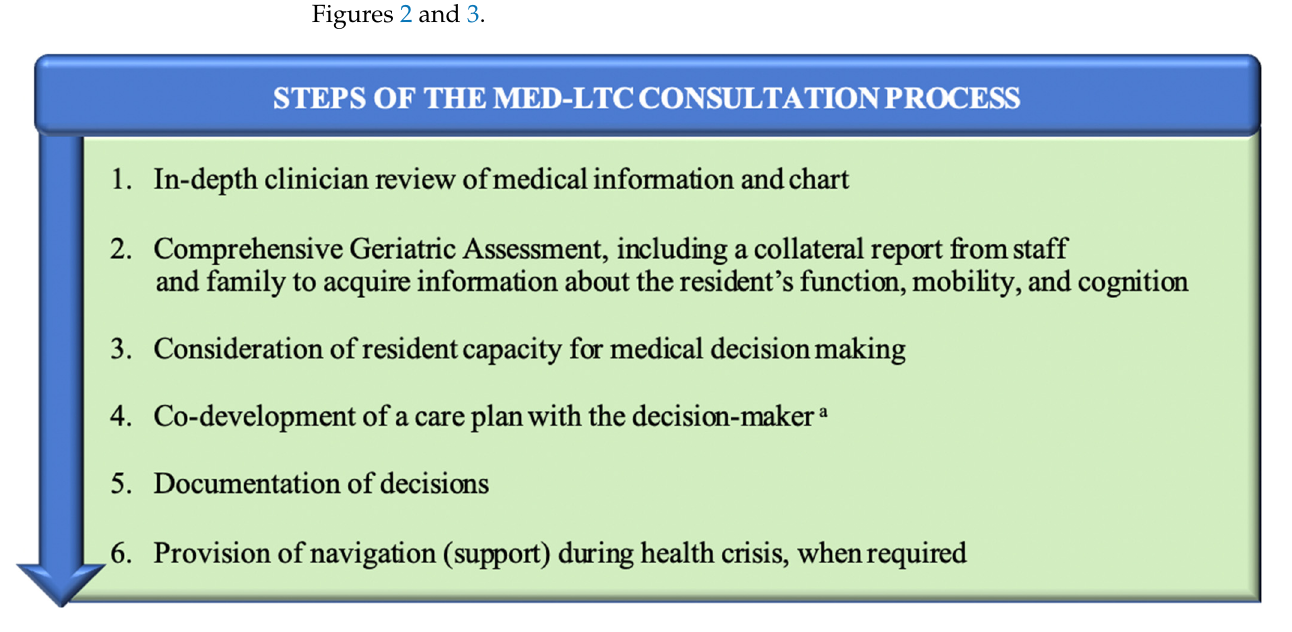
Figure 2. Steps of the Med-LTC Consultation process. a See Figure 3.